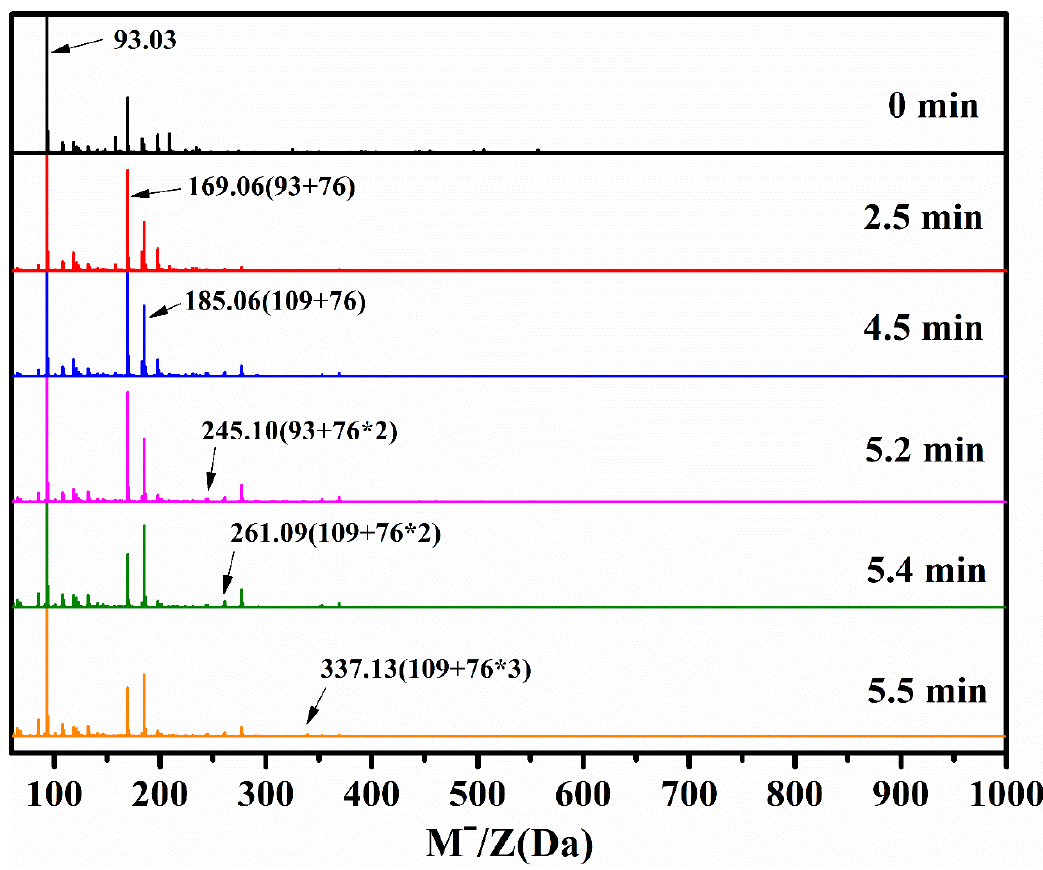
Figure 6. Q-TOF spectra of sodium phenolates with time at 495 °C.